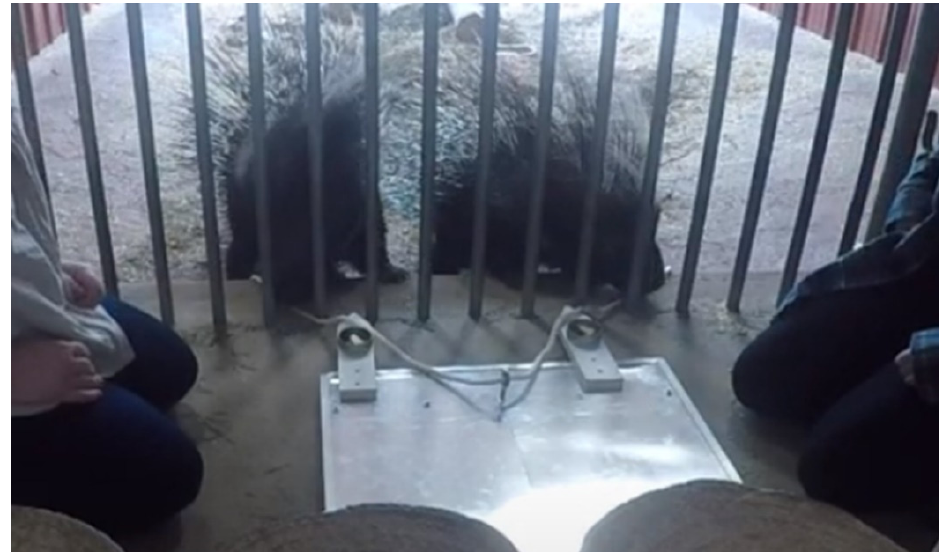
Figure 3. Apparatus used in the last 8 sessions of Phase 2.